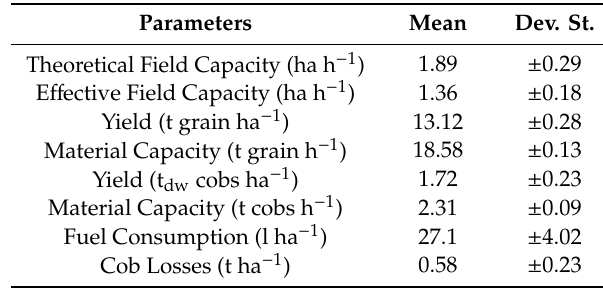
Table 4. Results of the maize and cob harvesting test with combine harvester (CASE IH 7140, Racine, WI, USA) and Harcob system.